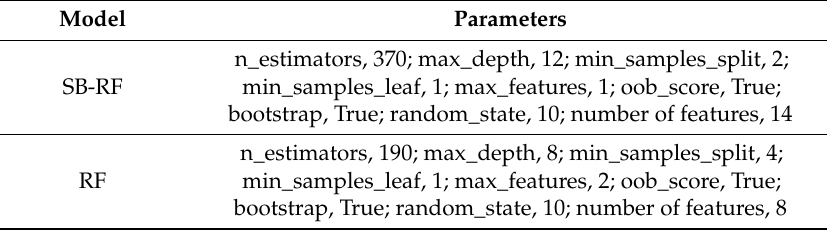
Table 2. The parameters of models utilized in this study.